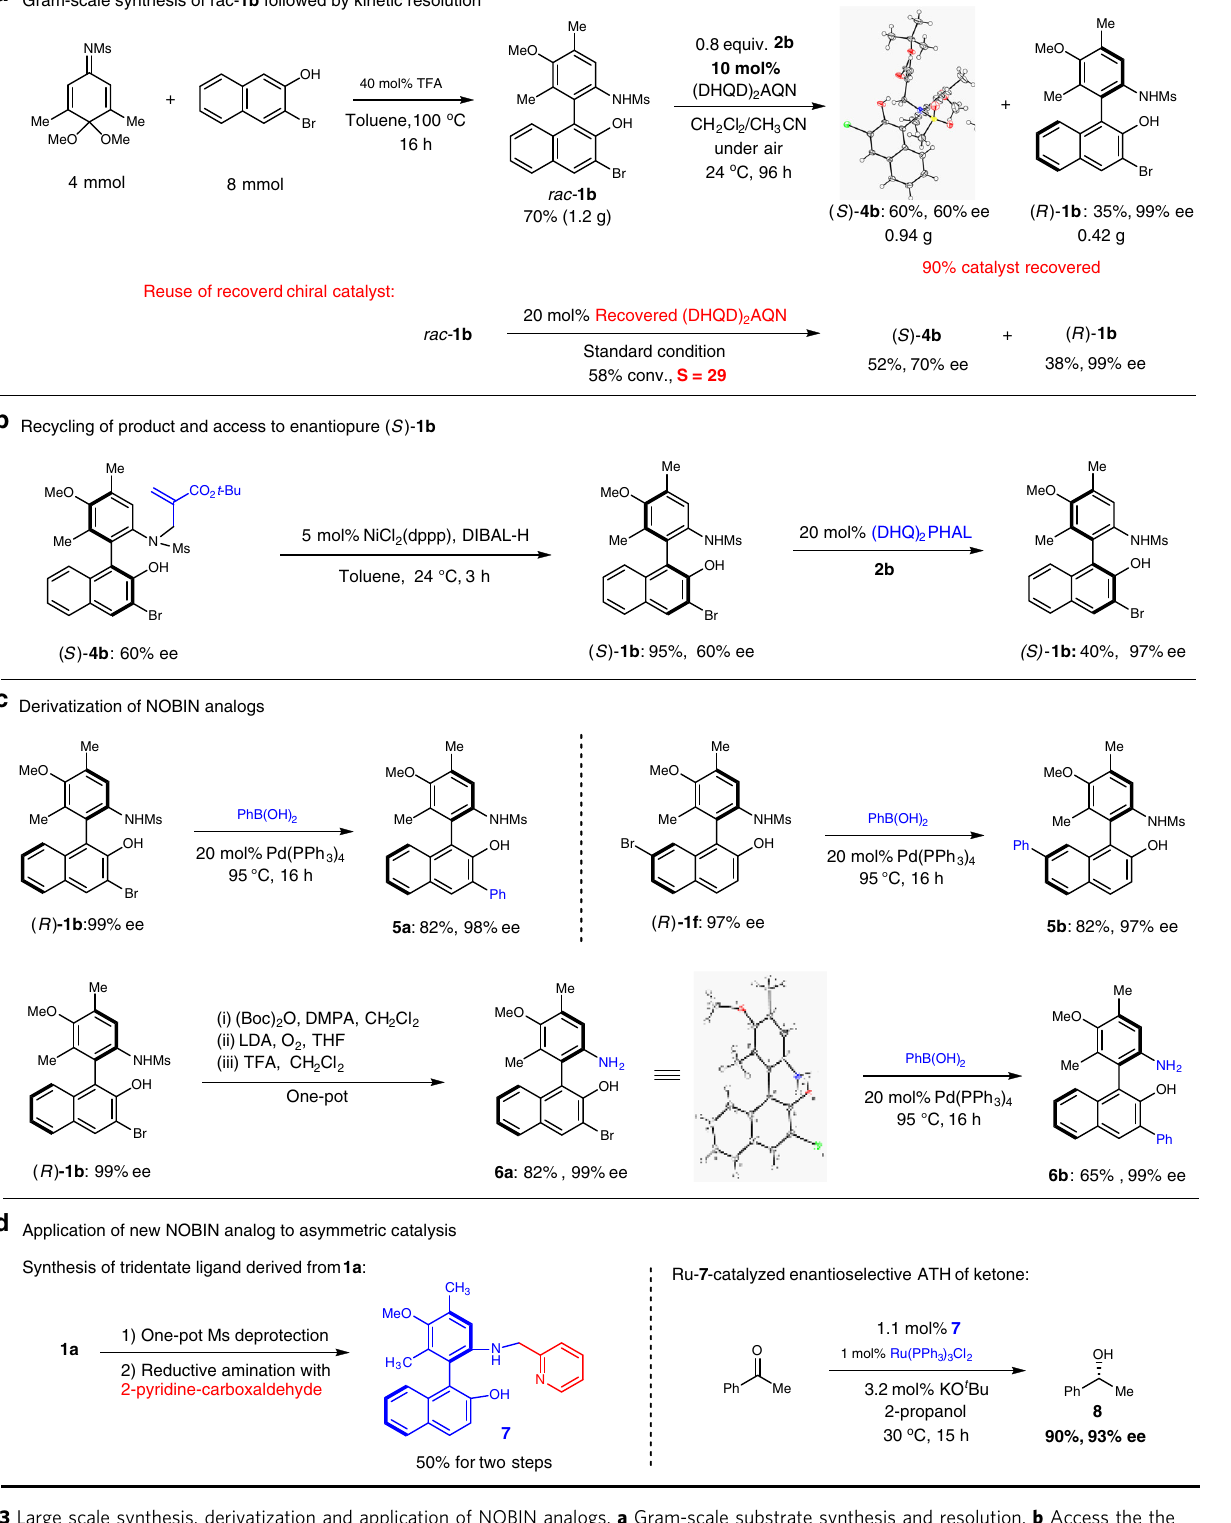
Fig. 3 Large scale synthesis, derivatization and application of NOBIN analogs. a Gram-scale substrate synthesis and resolution. b Access the the enantiomeric NOBIN analog. c Further derivatization to enlarge the scope of NOBIN analogs. d Application to asymmetric